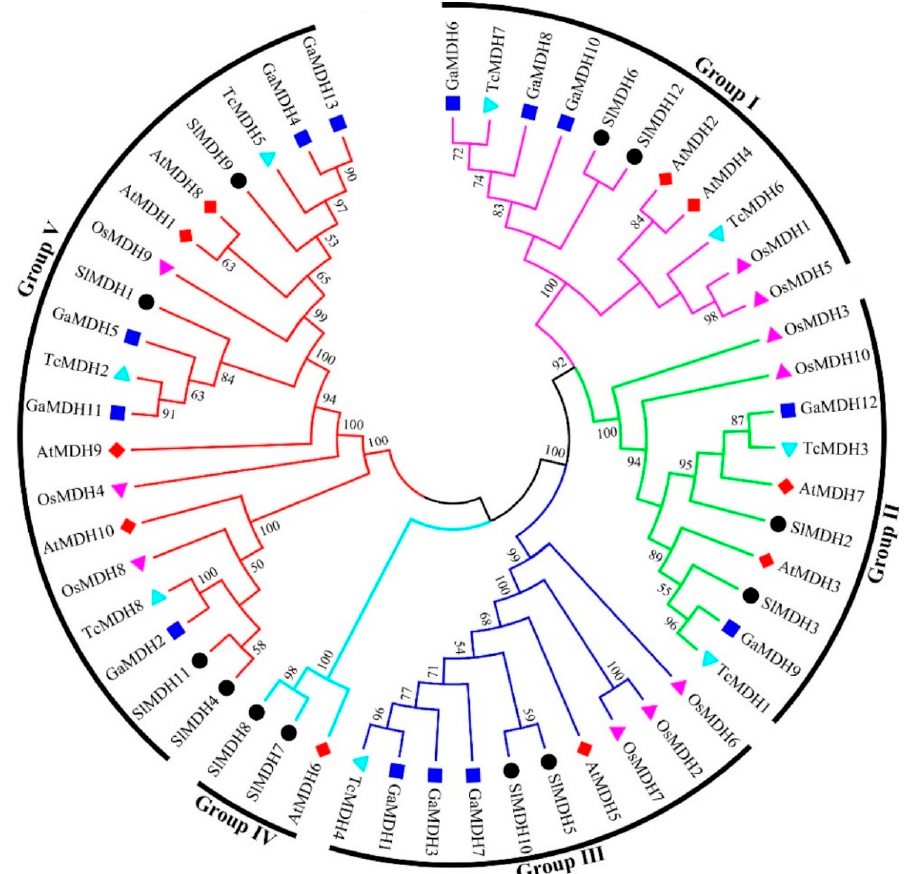
Figure 2. Phylogenetic relationships of MDHs from Solanum lycopersicum , Arabidopsis thaliana , Oryza sativa , Gossypium arboretum and Theobroma cacao . The un-rooted phylogenetic tree was generated with MEGA 6 using the neighbor-joining (NJ) method, and the bootstrap analysis was carried out with a total of 1000 replicates. The MDHs genes from Solanum lycopersicum , Arabidopsis thaliana , Oryza sativa , Gossypium arboretum, and Theobroma cacao were marked with a black circle, red rhombus, pink triangle, blue square, and cyan blue triangle, respectively. MDH proteins have 5 to 10 conserved motifs based on their groups but motif 1, motif 7, and